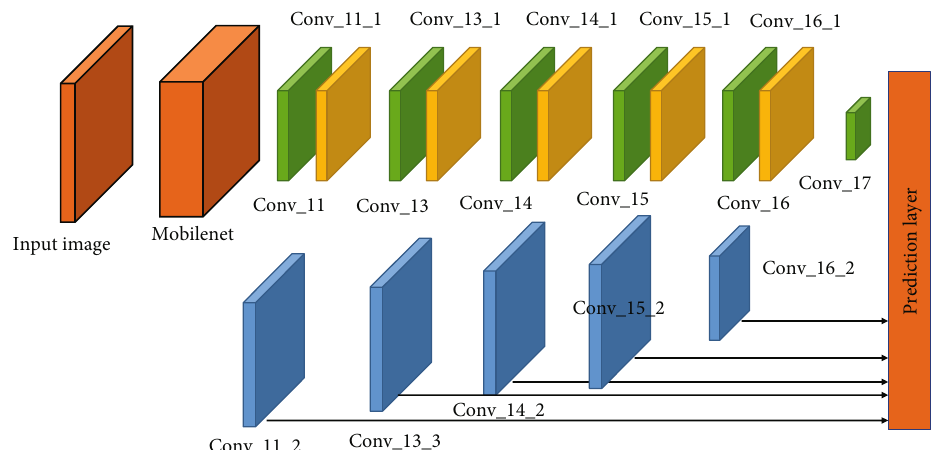
Figure 5: Multitarget detection algorithm network architecture diagram.